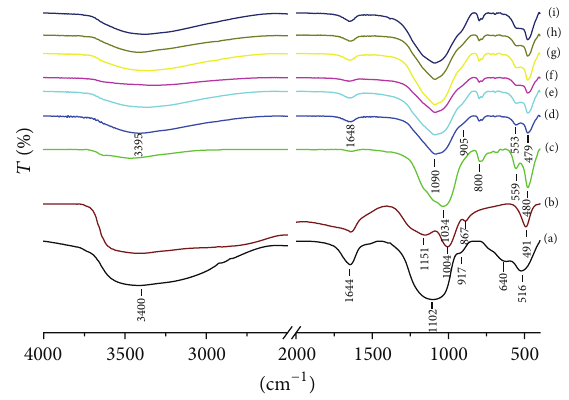
Figure 5: Compressive strength evolution of the phosphoric acid- basedgeopolymersG 𝑥